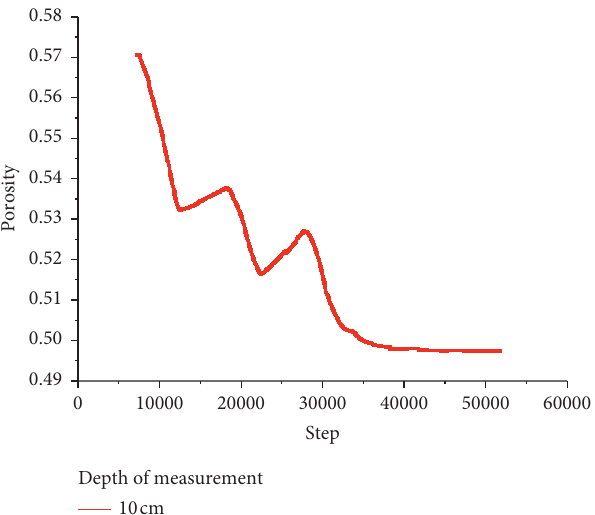
Figure 13: Curve of porosity change of 30cm thick reclaimed soil with three compactions.